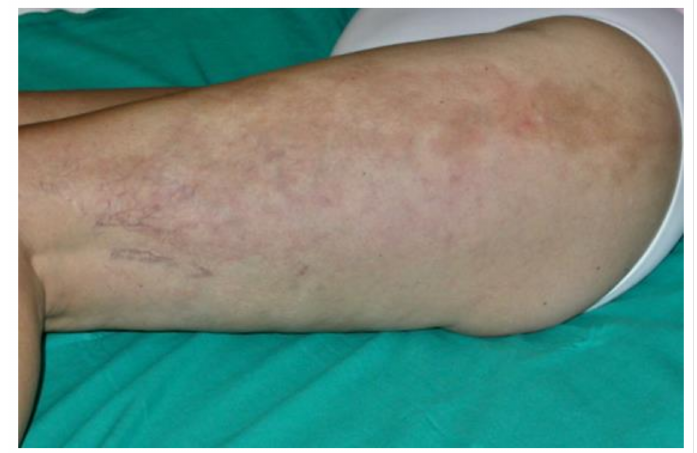
Figure 9. Acrodermatiitis chronica atrophicans. Borrelia afzelii was isolated from the biopsy specimen of the skin in BSK medium (photo by G.